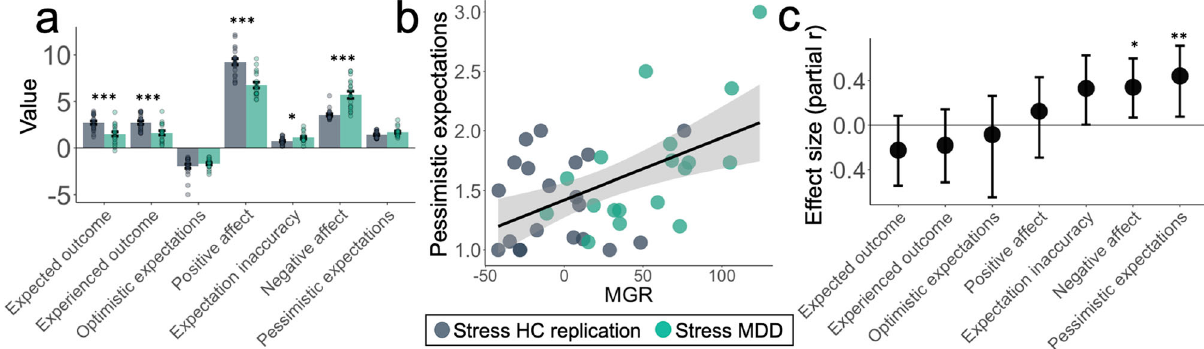
Fig. 4 Ecological momentary assessment and associations with maladaptive glutamate response. a Differences in ecological momentary assessment (EMA) ratings between healthy control (HC; n = 20 participants) and participants with major depressive disorder (MDD; n = 18 participants) with signi fi cance indicated as * p < 0.05, *** p < 0.001 ( t-test, two-tailed, uncorrected). Statistical comparisons were t 36 = − 3.98, p < 0.001 for expected outcomes, t 36 = − 3.74, p = 0.001 for experienced outcomes, t 35 = 0.96 p = 0.342 for optimistic expectations, t 36 = − 5.44, p < 0.001 for positive affect, t = 2.45, p = 0.019 for expectation inaccuracy, t = 5.62, p < 0.001 for negative affect, and t = 1.89, p = 0.066 for pessimistic expectations. Data 36 36 36 represented as mean ± standard error of the mean. b Association between maladaptive glutamate response (MGR) and pessimistic expectations from EMA, r 36 = 0.515, p < 0.001 (two-tailed, uncorrected). Shaded band represents 95% con fi dence interval. c Effect sizes (partial Pearson ’ s r , two-tailed, uncorrected) between MGR and EMA variables, controlling for age, sex, and diagnostic group ( n = 38 participants), r partial(33) = − 0.225, p = 0.193 for expected outcomes, r partial(33) = − 0.181, p = 0.299 for experienced outcomes, r partial(32) = − 0.085, p = 0.631 for optimistic expectations, r partial(33) = 0.123, p = 0.483 for positive affect, r = 0.330, p = 0.053 for ex p ectation inaccuracy, r = 0.341, p = 0.045 for negative affect and r = partial(33) partial(33) partial(33) 0.441, p = 0.008 for pessimistic expectations. Effect sizes and error bars (95%CI) were estimated using bootstrapping with 1000 samples and estimated separately for variables with different numbers of observations. Note that the optimistic expectations comparisons in a and c had one less degree of freedom than other variables, as one participant had no surveys with optimistic expectations. Source data are provided as a Source Data fi